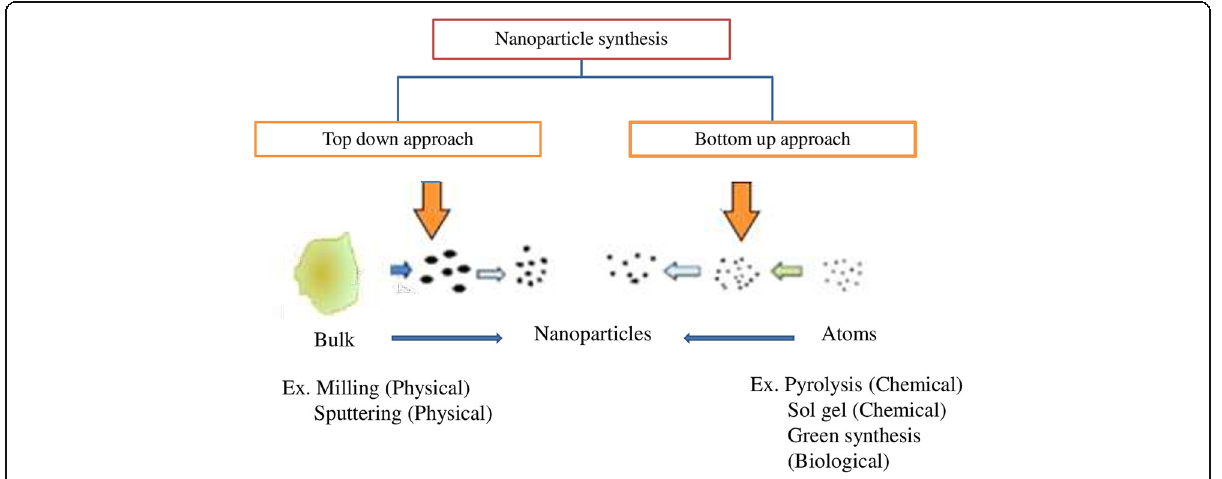
Fig. 2 Approaches of nanoparticles